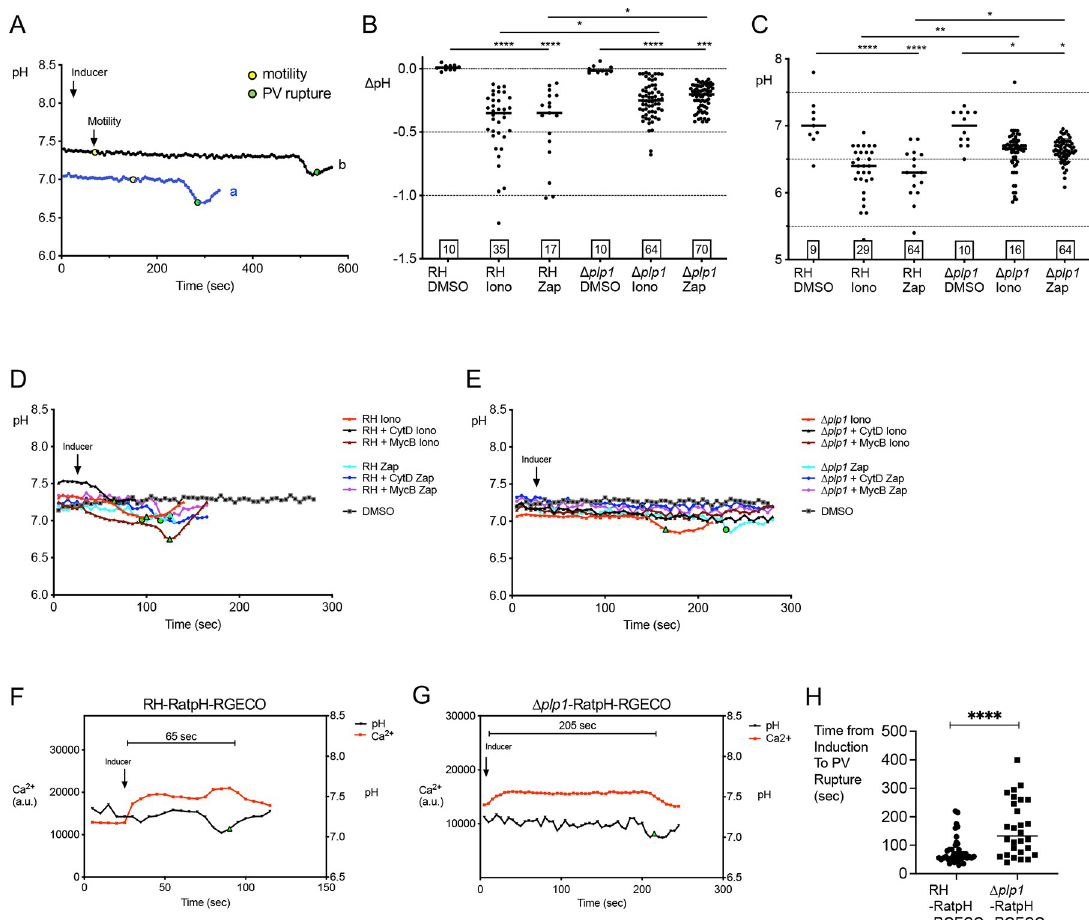
Fig 3. PV acidification is attenuated in Δ plp1 parasites. A) Representative tracings of pH values in Δ plp1 -RatpH from live imaging. Arrow indicates the time point that inducer was added. The yellow data points indicate the time point where motility of the tachyzoites began and the green points indicate the time of PV rupture. B) Δ plp1 PVs show a significant attenuation of PV acidification after induction with ionomycin or zaprinast. Each point represents the change in pH within an individual PV. RH-RatpH data sets are the same as those presented in Fig 1F. Values in squares within the graph indicates the numbers of PVs enumerated. RH, RH-RatpH; Δ plp1 , Δ plp1 -RatpH. C) Punctate foci in individual vacuoles reach lower pH than whole vacuole. Ratio images of RH-RatpH or Δ plp1 -RatpH vacuoles were analyzed in ImageJ using the Process Plugin to find min-max values (v.1.00). Data points indicate the lowest pH measured within a PV. RH, RH-RatpH; Δ plp1 , Δ plp1 -RatpH. Kruskal-Wallis tests with Dunn’s multiple comparison were performed for B) and C). � p � 0.05, �� p � 0.01, ���� p � 0.001, ���� p � 0.0001. Bars indicate the median. D) Paralyzed WT parasites undergo PV acidification. Representative traces of RH-RatpH parasites untreated or immobilized with cytochalasin D (CytD) or mycalolide B (MycB), followed by ionomycin or zaprinast induction. RH, RH-RatpH; Δ plp1 , Δ plp1 -RatpH. E) Representative traces of Δ plp1 -RatpH parasites untreated or immobilized with CytD or MycB, followed by ionomycin or zaprinast induction. F,G) Kinetics of parasite Ca 2+ signaling relative to PV acidification. Representative traces of relative Ca 2+ levels (left axis) and pH (right axis) of RH-RatpH-RGECO PVs (F) and Δ plp1 - RatpH-RGECO PVs (G) following zaprinast induction. a.u., arbitrary units. H) Enumeration of 41 RH-RatpH-RGECO and 28 Δ plp1 - RatpH-RGECO PVs shows an increase in the time from addition of inducer to PV rupture in Δ plp1 -RatpH-RGECO. A two-tailed student’s t -test was performed, ���� p �